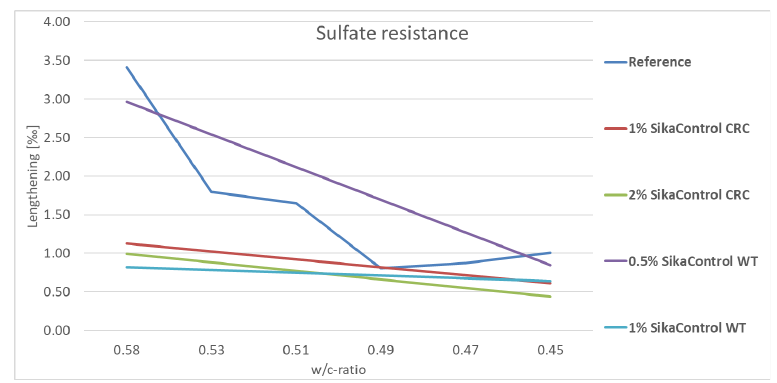
Figure 10. Reference concrete with various w/c-ratios: Sulfate resistance.